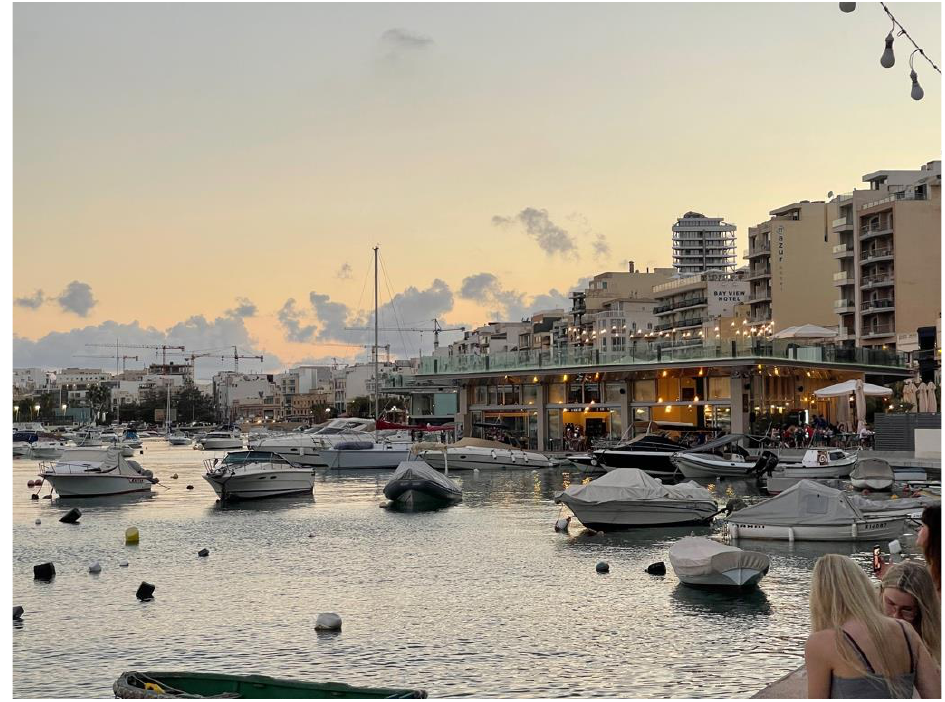
Figure 3 . Businesses operating along the Sliema promenade.